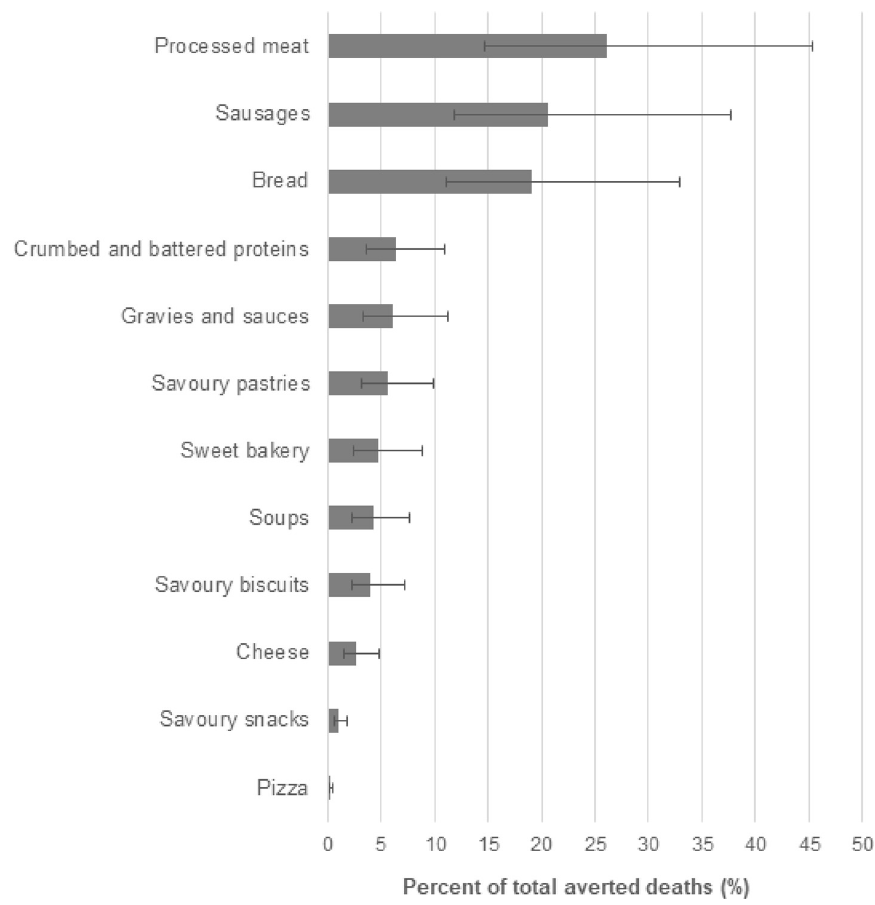
Fig 3. The proportion of deaths from CVD, CKD, and stomach cancer averted each year by food category if the Australian government’s current sodium reformulation targets were achieved. Error bars indicate 95% UIs. Food categories with greatest potential to prevent all-cause death include processed meat ( n = 134 averted deaths), sausages ( n = 107), and bread ( n = 98). CKD, chronic kidney disease; CVD, cardiovascular disease; UI, uncertainty interval.